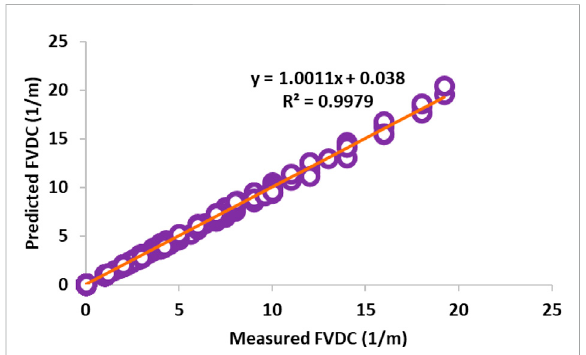
FIGURE 16 llustration of cross plot of new robust LSSVM-PSO algorithm structered by training subset of well #W1 for prediction FVDC related to wells #W2.